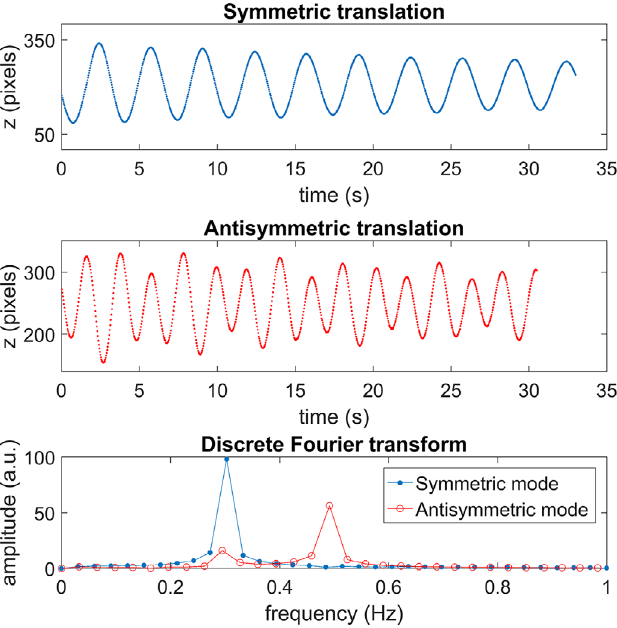
Fig. 8. Translation movement and associated spectral analysis of each normal